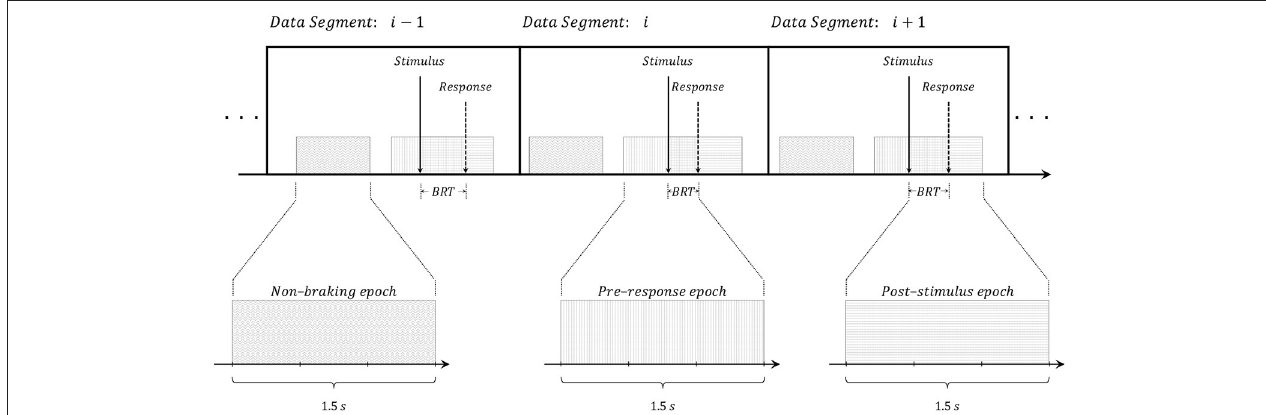
FIGURE 3 | Graphical illustration of the data segments and the three types of epochs extracted from each of them: ( i ) Non-braking epochs: signals of 1.5 s that are more than 3 s apart from any stimulus and/or response (data without emergency braking); ( ii ) pre-response epochs: signals in the time interval [ − 1.5, 0] s where the reference t = 0 corresponds to the response (the first notable deflection of the participant’s vehicle brake pedal); ( iii ) post-stimulus epochs: signals in the time interval [0, 1.5] s where the reference t = 0 corresponds to the stimulus (the guide vehicle switching-on of the rear brake